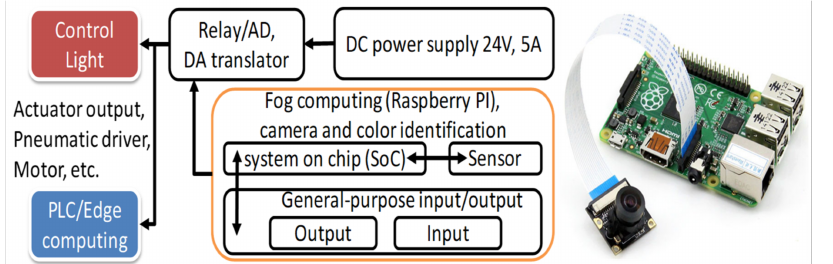
Figure 8. The Raspberry Pi circuit connected to AD signal structure; 4.5 Cloud high-end